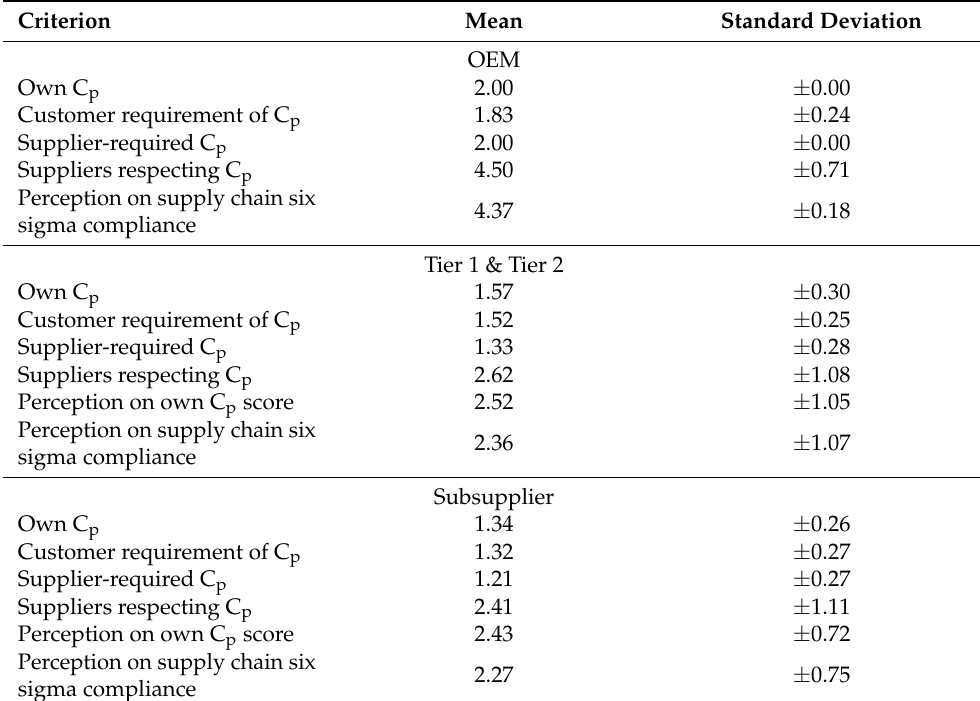
Table 2. Answers and means and percentage or standard deviation.